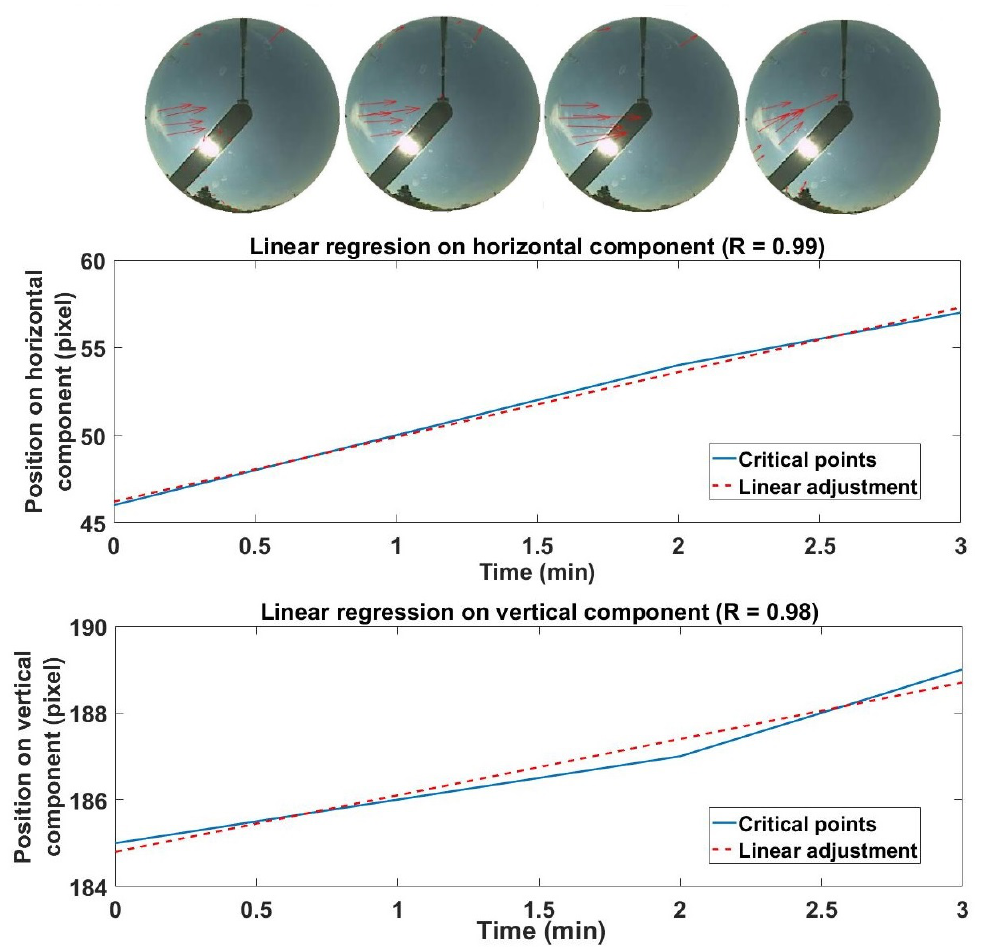
Figure 6. Linear regression. R = 0.99 (horizontal component) and R = 0.98 (vertical